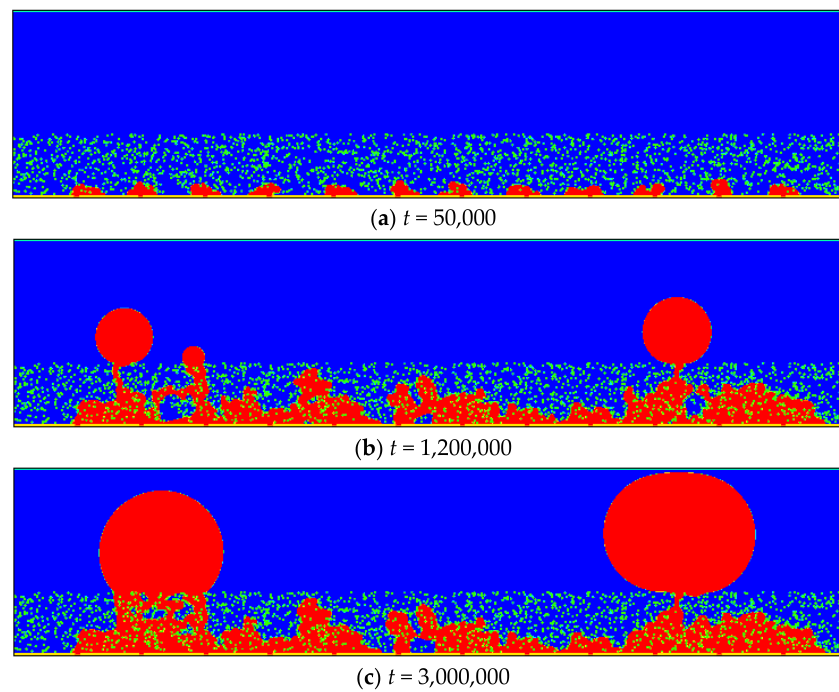
Figure 9. Time evolutions of liquid water distribution in the domain with 12 fractures.